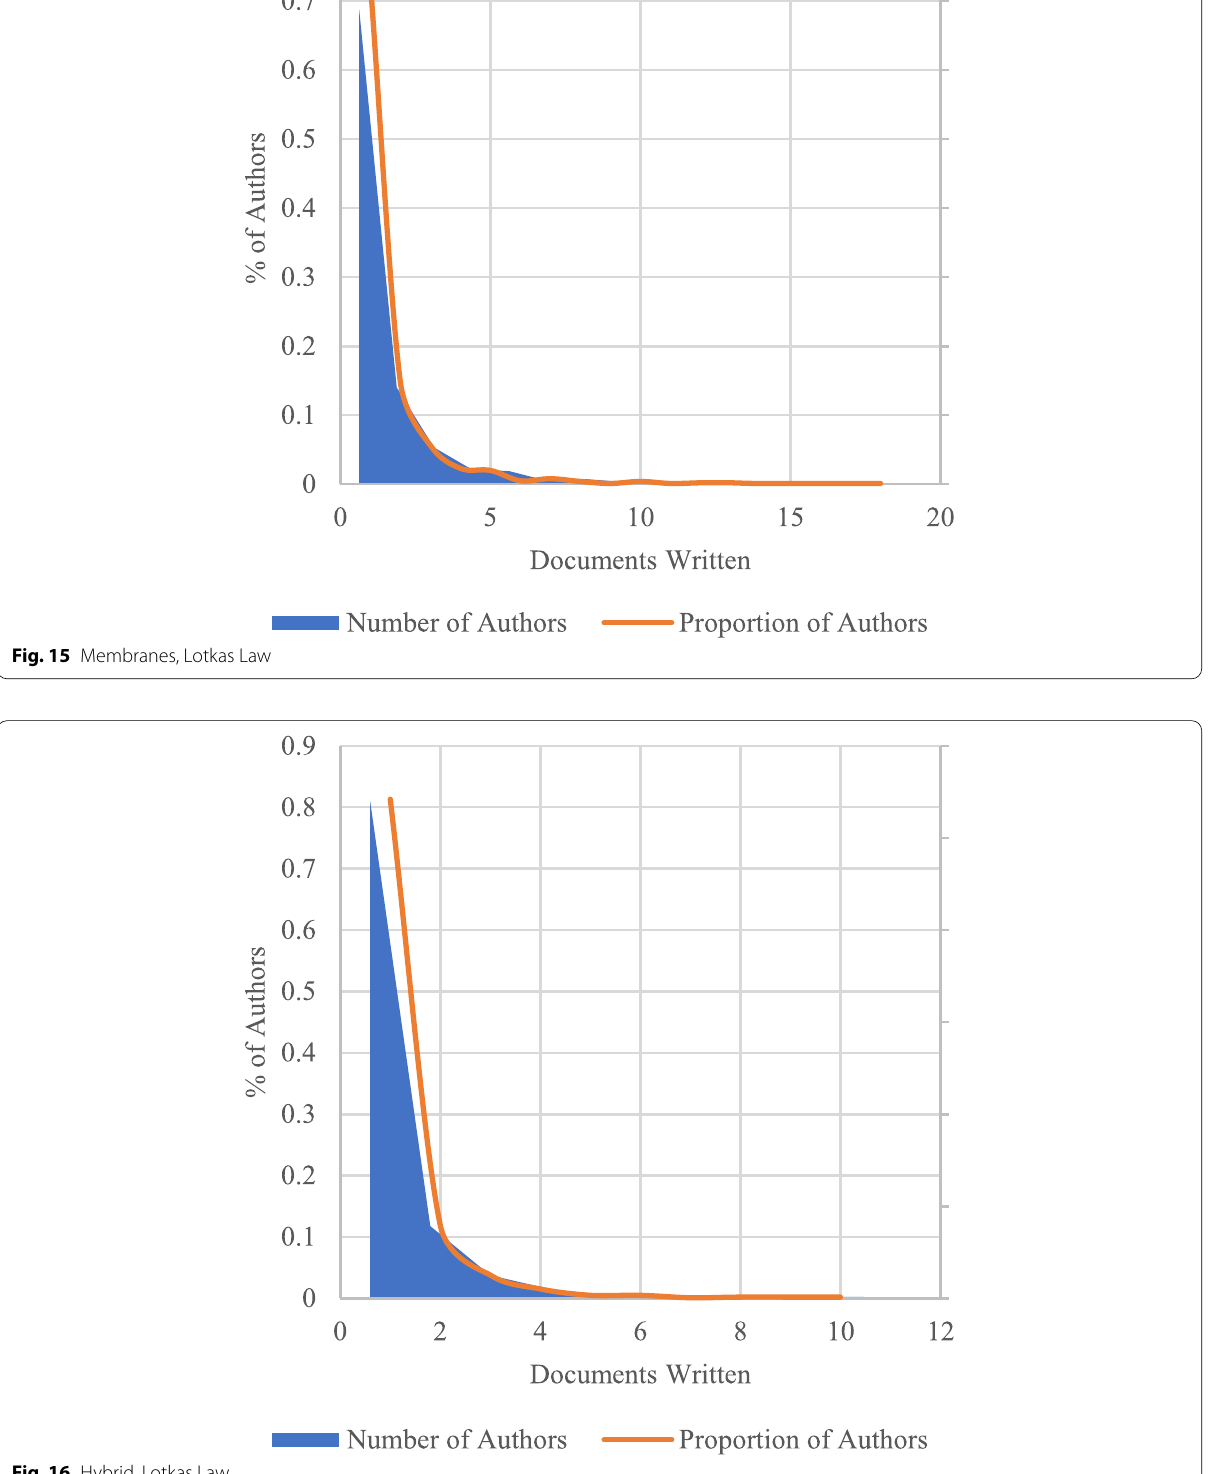
Fig. 16 Hybrid, Lotkas